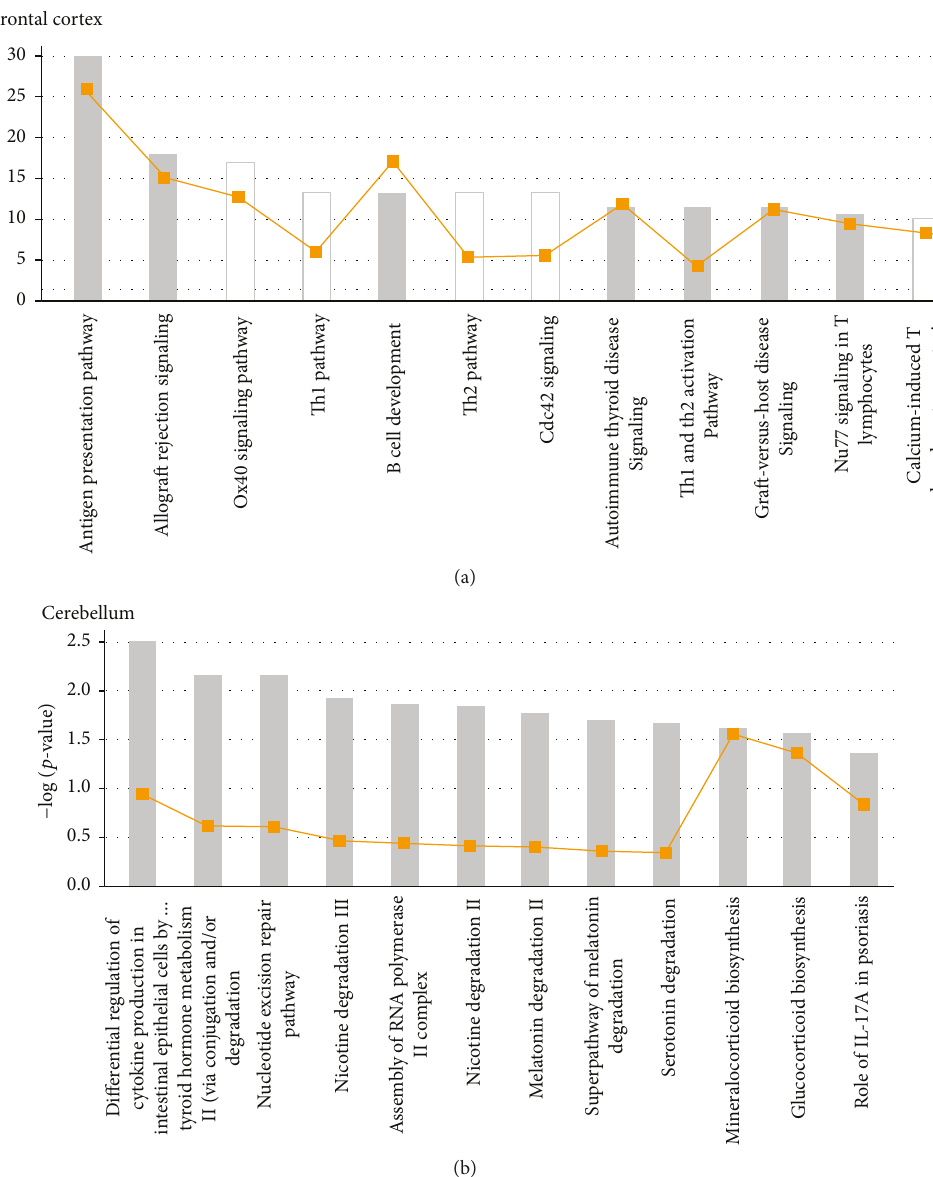
Figure 4: Top canonical pathways identi fi ed in ingenuity pathway analysis (IPA). The x -axis represents the top canonical pathways calculated by IPA based on all DNA copy number variations (CNVs) identi fi ed in the frontal cortex (a) and cerebellum (b). The yellow line represents the threshold of p value < 0.05 as calculated by Fischer ’ s